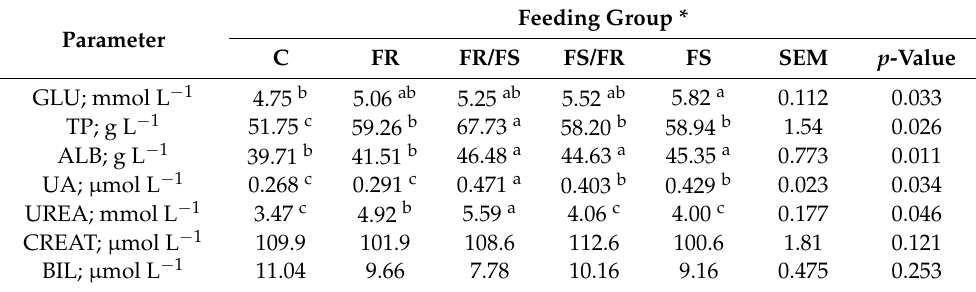
Table 2. Effect of fermented components on biochemical parameters of the blood plasma of piglets. Feeding Group * Parameter C FR FR/FS FS/FR